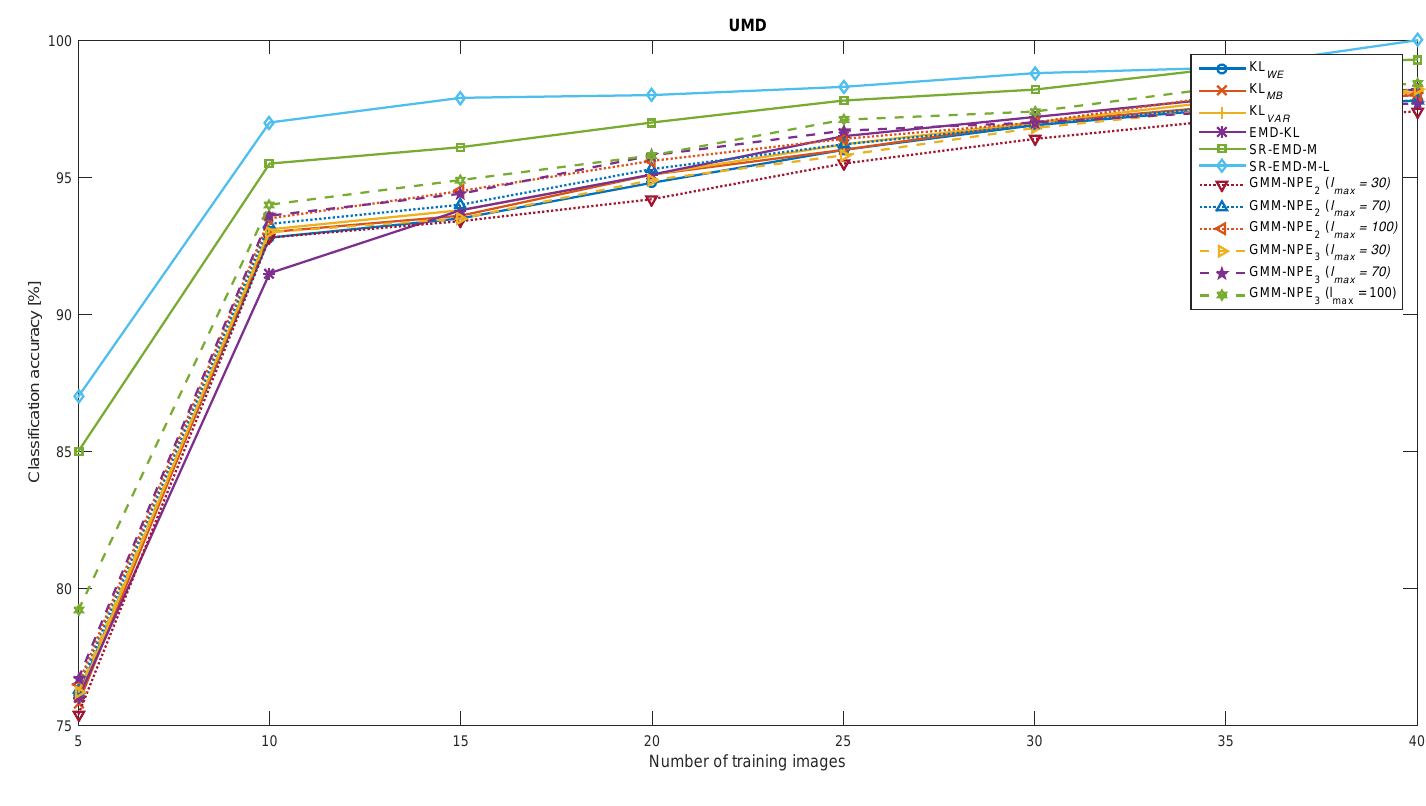
Figure 3. Classification rate vs. the number of training examples for the KTH-TIPS texture database for the proposed method in comparison to baseline